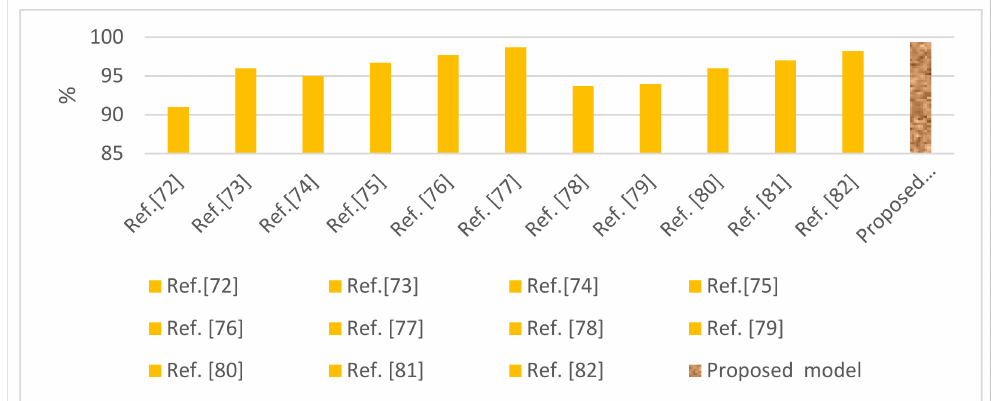
Figure 21. Comparative performance of the proposed system against existing systems in the detection of malware against Android applications using the Drebin dataset.